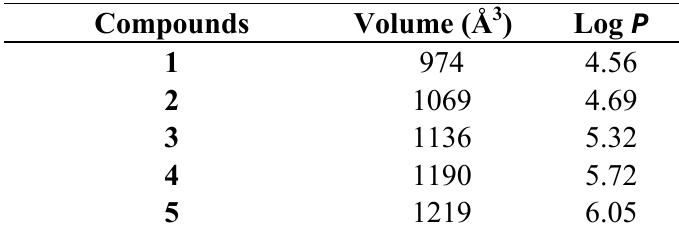
Table 3. Volume and log P values of the diterpenoids.